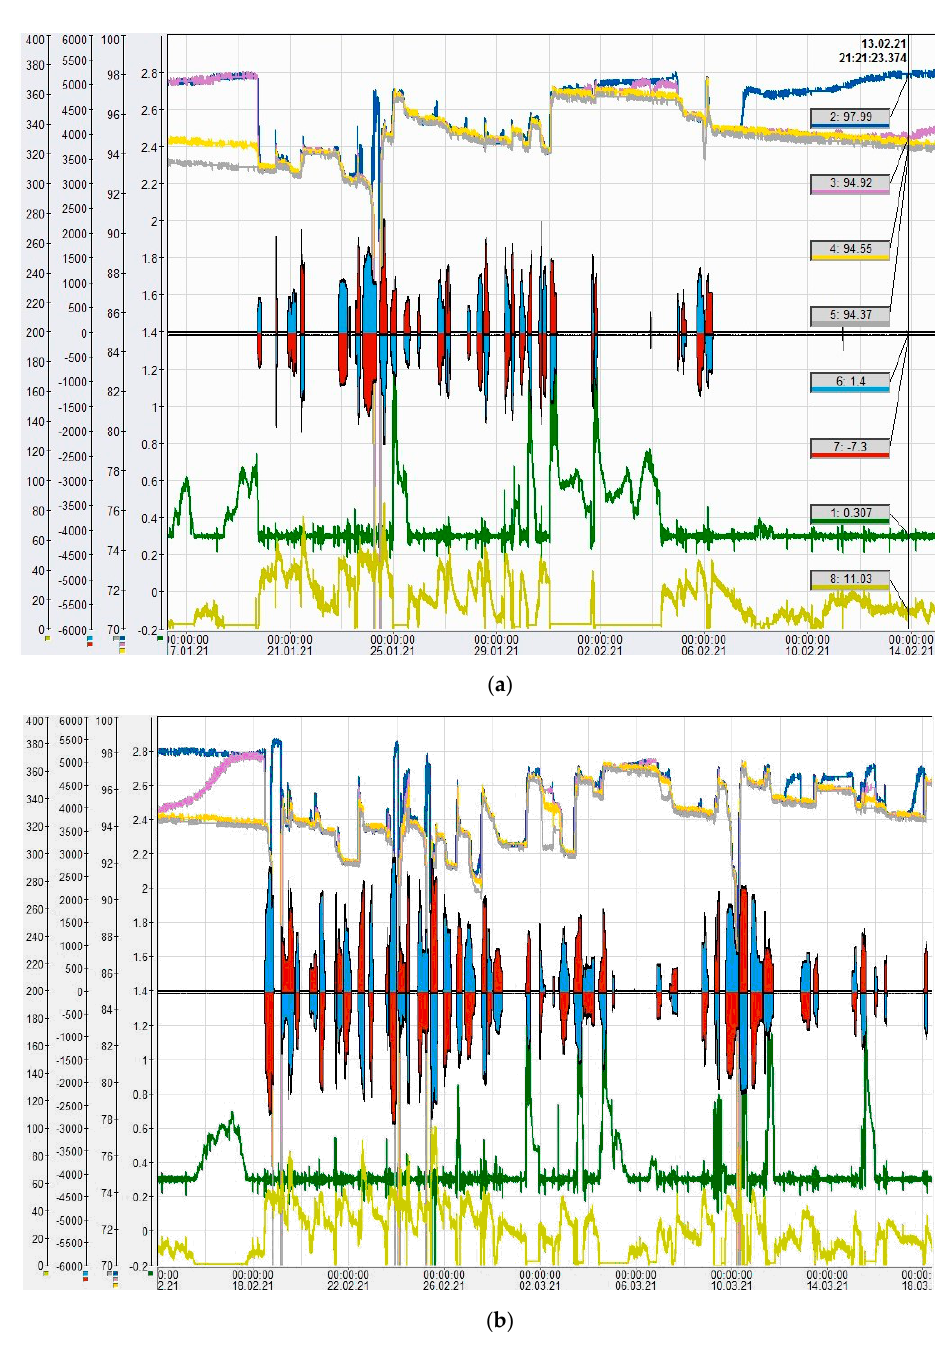
Figure 6. Data for 2.5 months’ operation (from 7 January 2021 to 13 February 2021 (a) and from 14 February 2021 to 18 March 2021 (b) ) of the TES with steam cushion system for CHP in